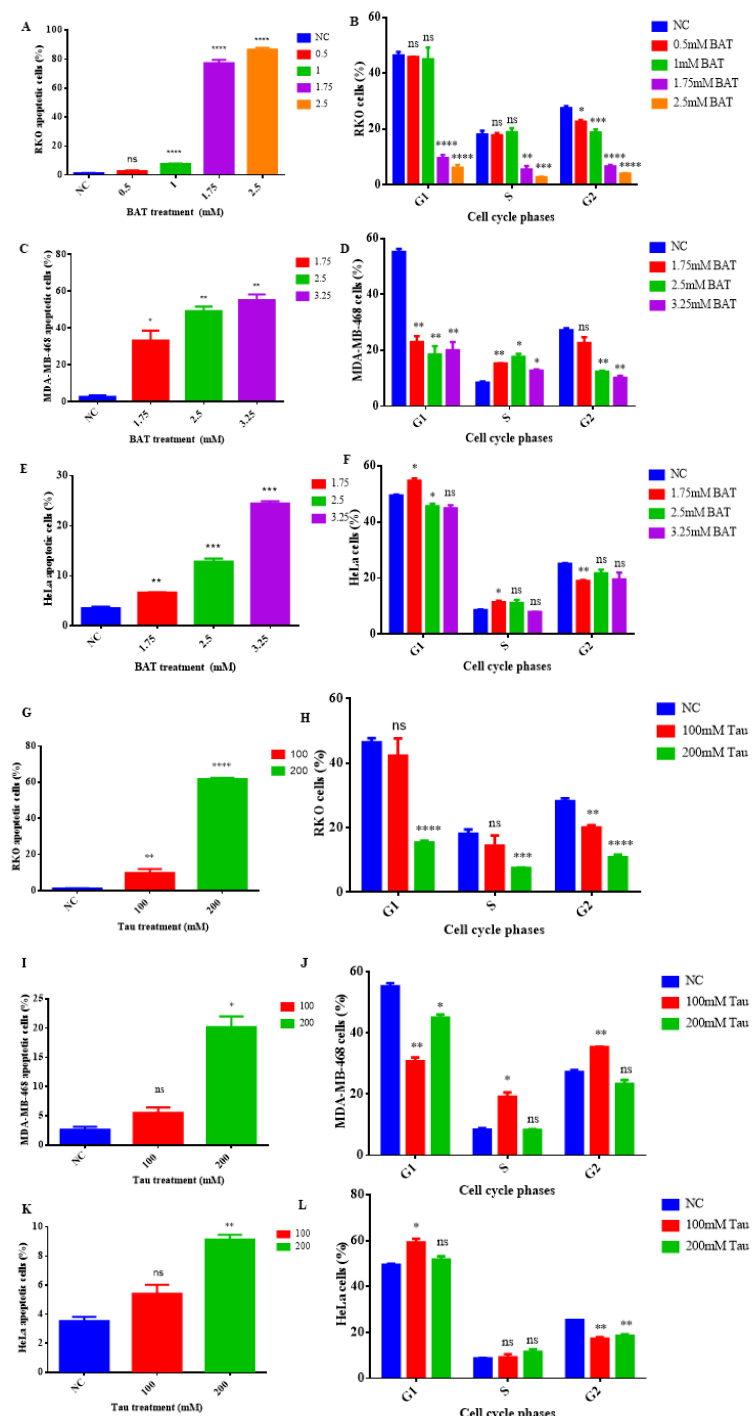
Figure 5. BAT and Tau do not affect cancer cell cycle regulation: RKO ( A , B , G , H ), MDA-MB-468 ( C , D , I , J ), and HeLa cells ( E , F , K , L ) were treated with the indicated concentrations of BAT ( A – F ) or Tau ( G – L ) for 48 h in a cell-type-dependent manner. Cells were stained with propidium iodide (PI) and they were subjected to flow cytometry (FACS) analysis to determine the cell distributions in each phase of the cell cycle in the treated groups versus negative control (NC), using BD FACS Calibur and CellQuest Pro software. Graphs ( A , C , E ) and ( G , I , K) show the percentage of apoptotic cells and statistical analysis compared to NC, following the treatment with BAT and Tau, respectively. Graphs ( B , D , F) and ( H , J , L ) show the percentage of cells in each phase of cell cycle of non-apoptotic cells and statistical analysis compared to NC, upon the treatment with BAT and Tau, respectively. ns: not significant, * p < 0.05. ** p < 0.01. *** p < 0.001, **** p <